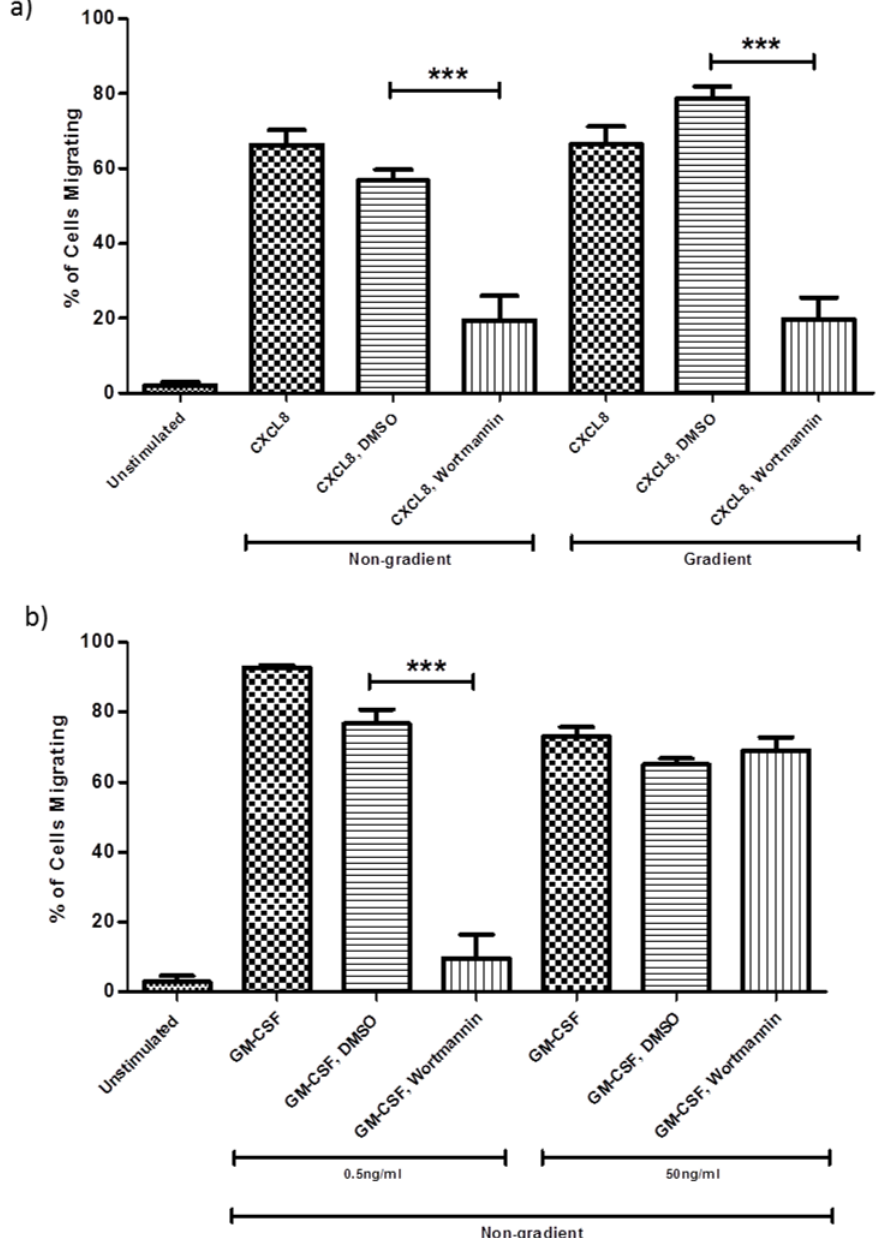
Fig 3. Wortmannin inhibits both CXCL8 and GM-CSF-mediated neutrophil migration. Neutrophils were pre-treated for 30 mins with 50nM wortmannin, and then stimulated with a) CXCL8 (100ng/ml) or b) GM-CSF (0.5ng/ml, 50ng/ml). Results are shown as mean ± SEM (n = 7) except for DMSO controls and 0.5ng/ml GM- CSF where n = 3, *** p < 0.001.